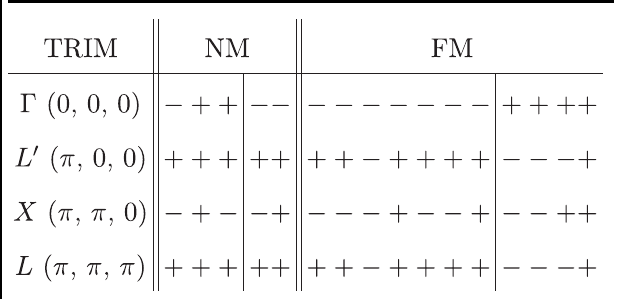
Table 1. Band parities at time reversal invariant momenta (TRIMs) in the non-magnetic (NM) and ferromagnetic (FM)